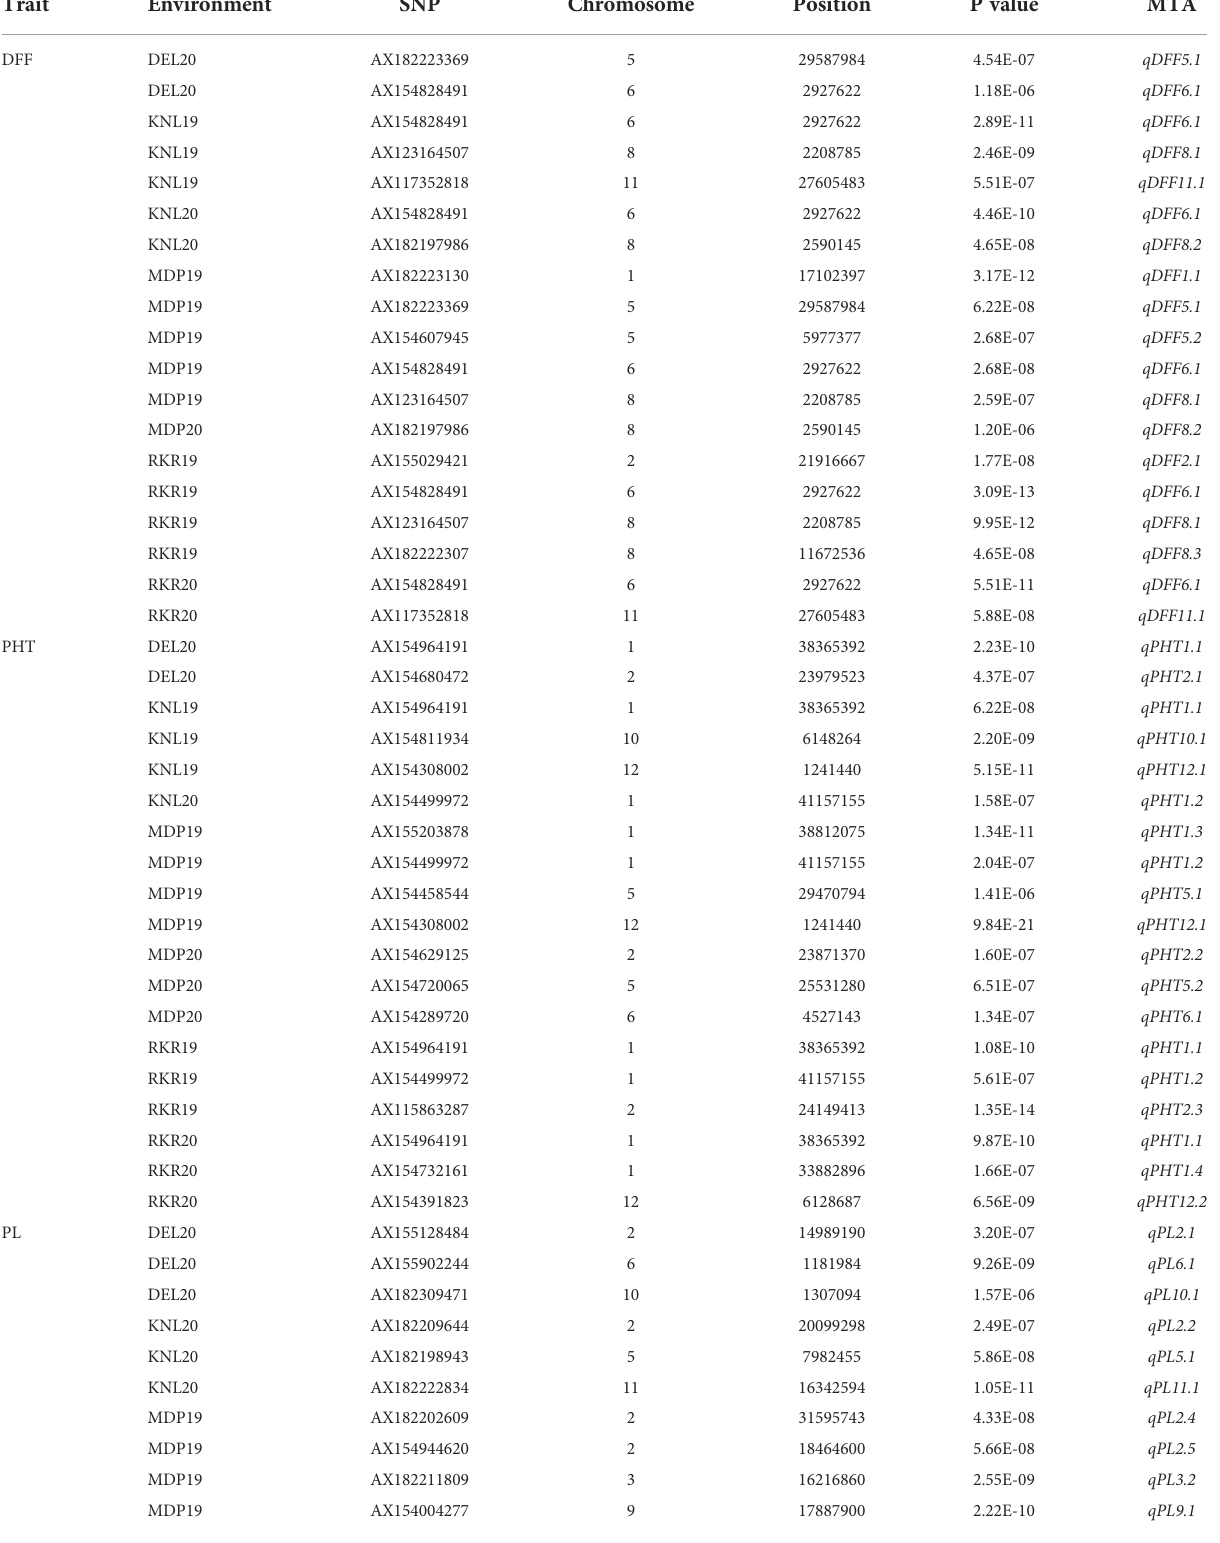
TABLE 3 Marker trait associations (MTA) detected in GWAS by using BLINK model for the agronomic traits in seven environments.